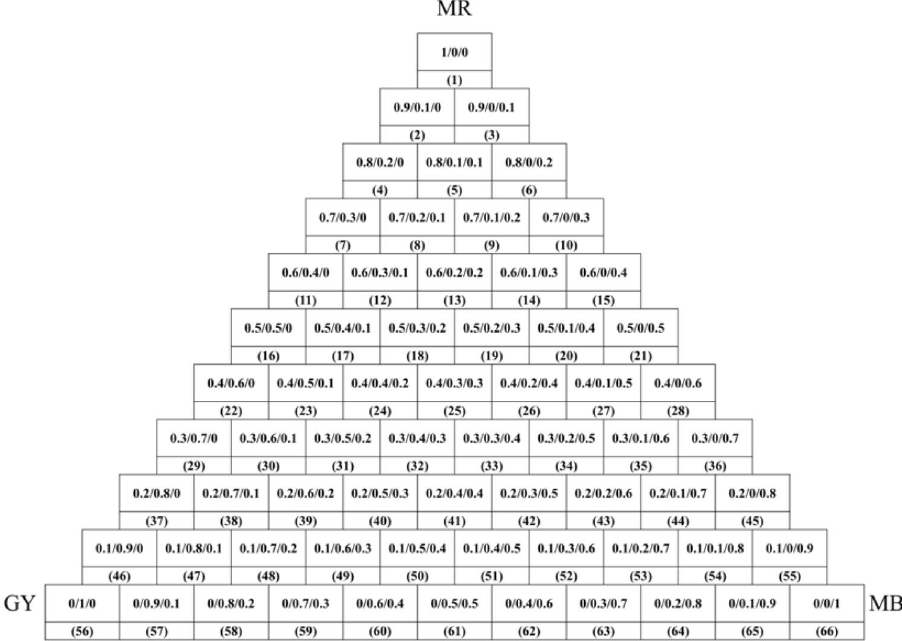
Figure 3. Color triangle of wool yarn dyeing using MR, GY, and GB dye mixtures with various dye mass